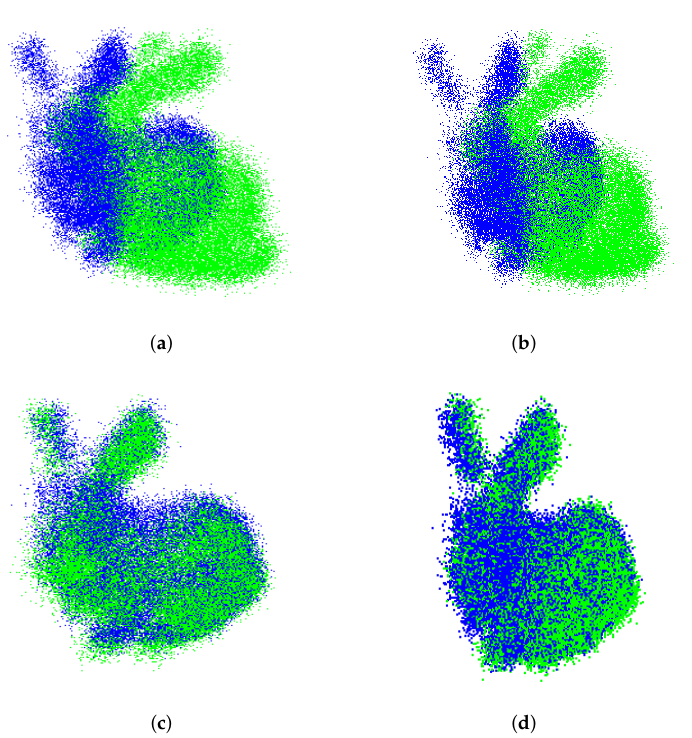
Figure 9. Alignment of Bunny model with added noise. ( a ) Go-ICP. ( b ) Go-ICP Trim. ( c ) FPFH approach. ( d )